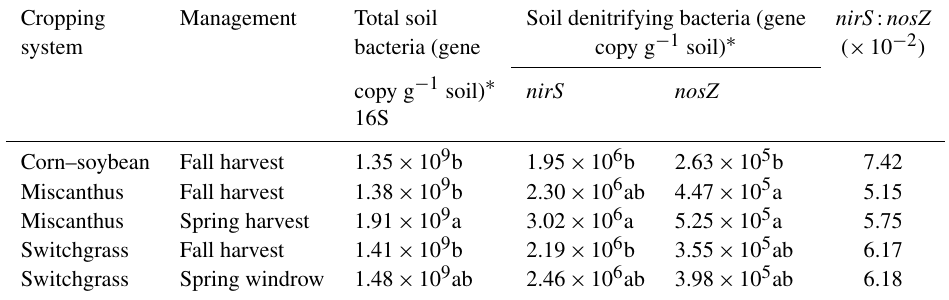
Table 2. Mean gene abundance responses to crop and harvest management, averaged over nitrogen application rate and time at the Elora Research Station.